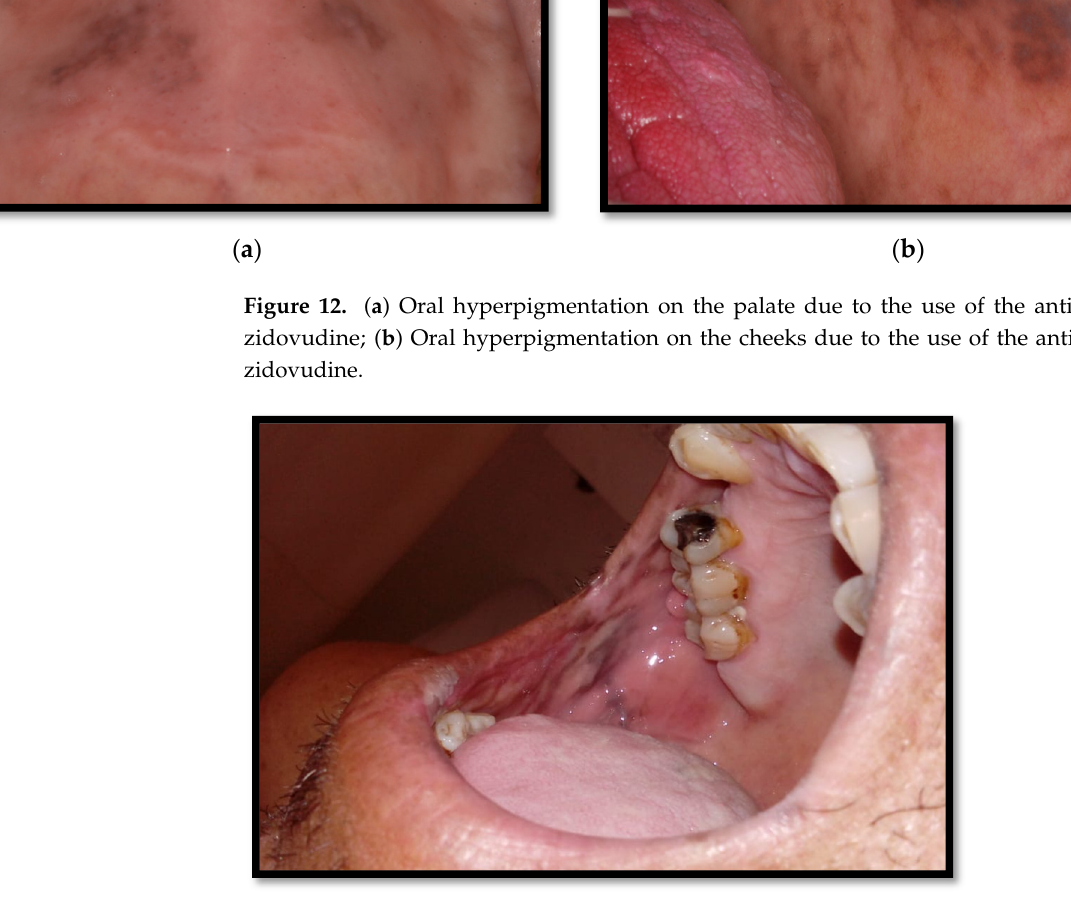
Figure Figure 13. Hyperpigmentation in the lip mucosa, with severe dental destruction “methampheta- mine mouth”.